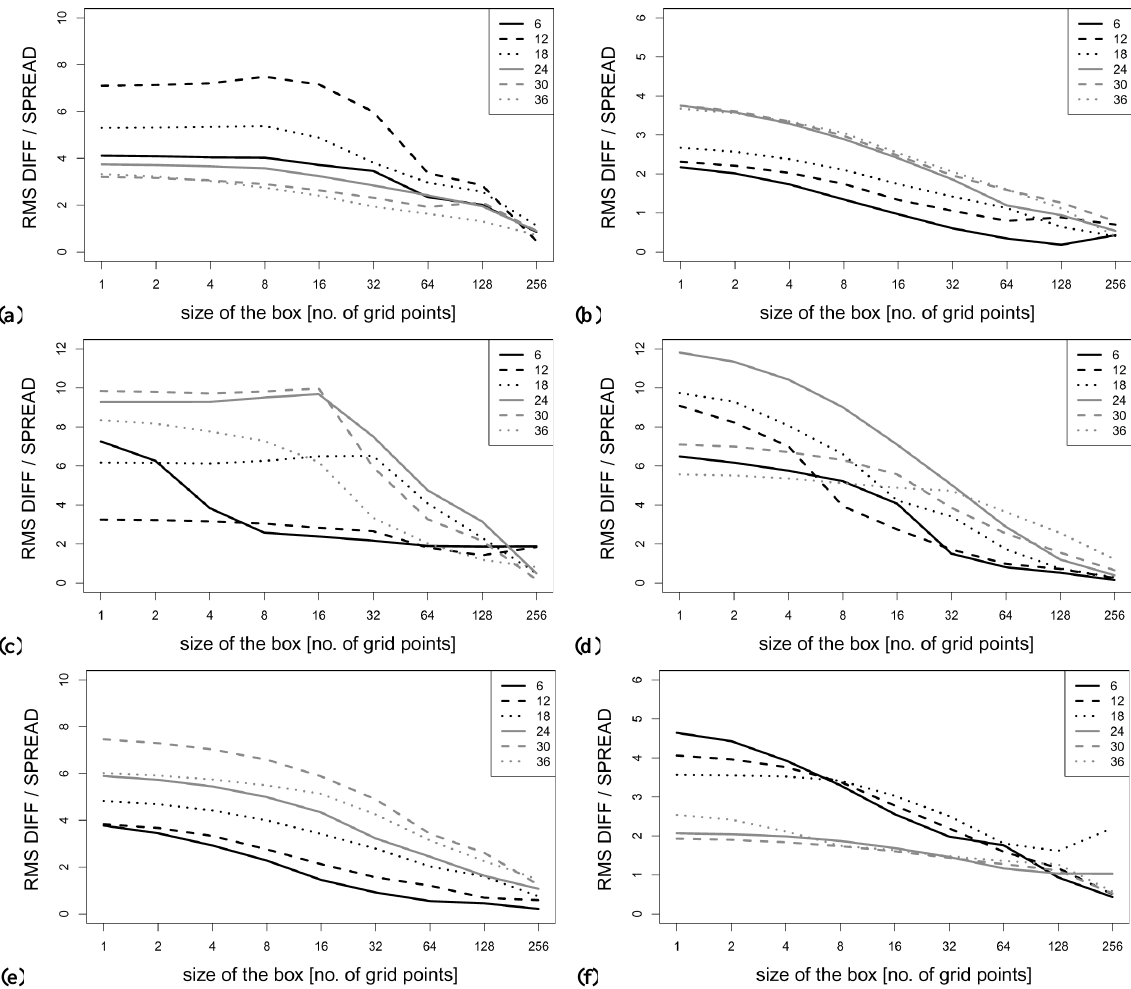
Fig. 6. Ratio between the RMS difference between all the members of the two ensembles and the spread of COSMO-H2-EPS as a function of the horizontal scale of upscaling (indicated as the size, in grid points, of each upscaling box) in terms of 6h accumulated precipitation for the different forecast ranges (from 0–6 to 30–36h). Plots are for the cases (from top left to bottom right): 2012092512, 2012093012, 2012101612, 2012101712, 2012102212,